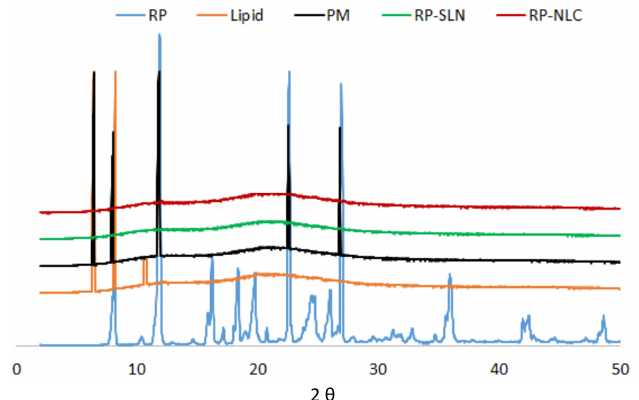
Figure 4. XRD spectra of pure drug, pure lipid, physical mixture of drug and lipid, lyophilized optimized RP-SLN formulation and RP-NLC